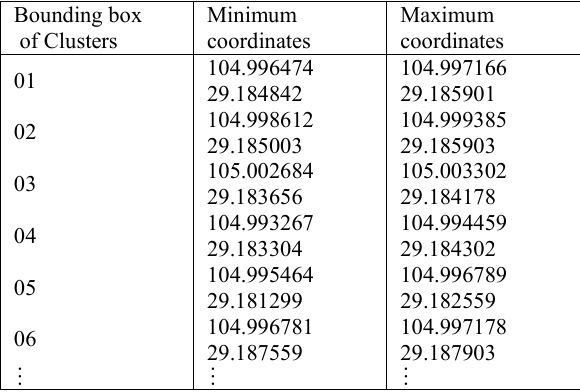
Table 4 . The Coordinates of bounding